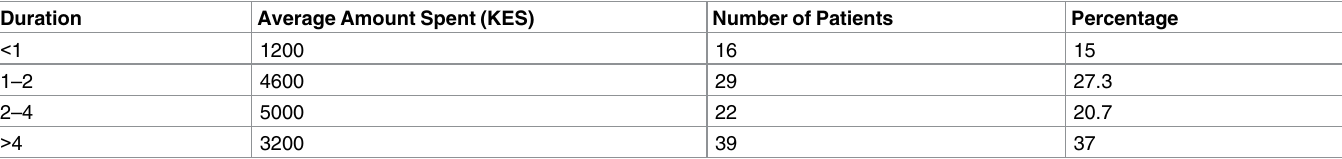
Table 3. Cross tabulation of duration before correct diagnosis and amount spent (n = 106).